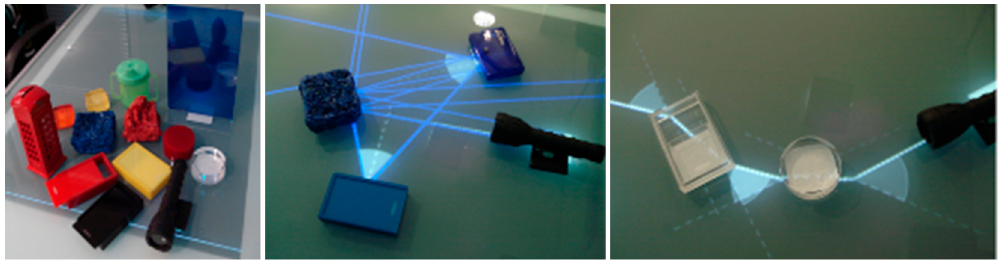
Figure 2. Different shapes, materials, and colours of the objects ( left ) and the effects some of them produce ( centre and right ) in the LightTable.